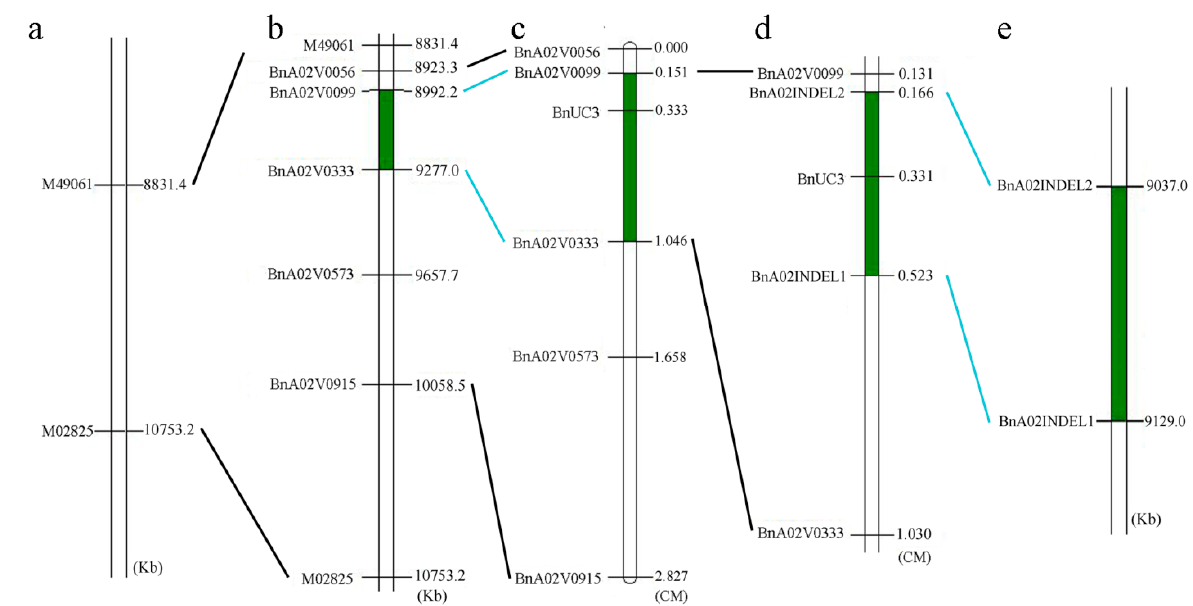
Figure 3. Mapping of the BnUC3 locus ( a – e ). M49061 and M02825 are SNP markers on chromosome A02. Markers with prefix BnA02V are SSR markers. BnaA02INDEL1 and BnaA02INDEL2 are InDel markers. Physical map location is based on ZS11 reference genome sequence.